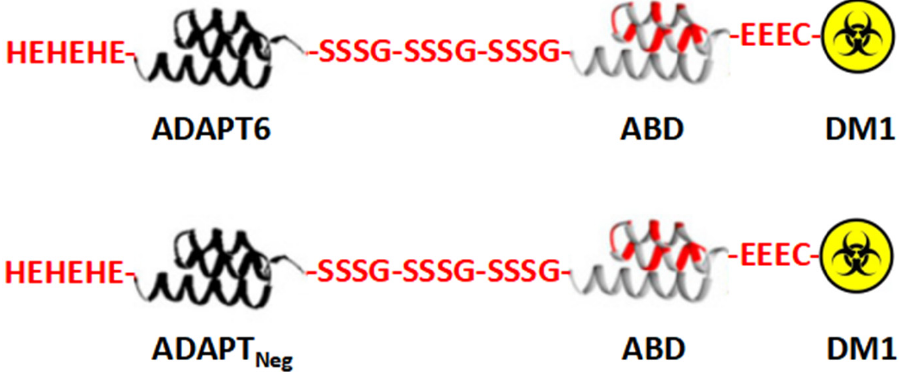
Figure 1. Schematic representation of the molecular design of the conjugates consisting of an albumin-binding domain (ABD) derived affinity protein (ADAPT6 or ADAPT Neg ), a (SSSG) 3 linker, an ABD and the cytotoxic drug DM1, used in this study.